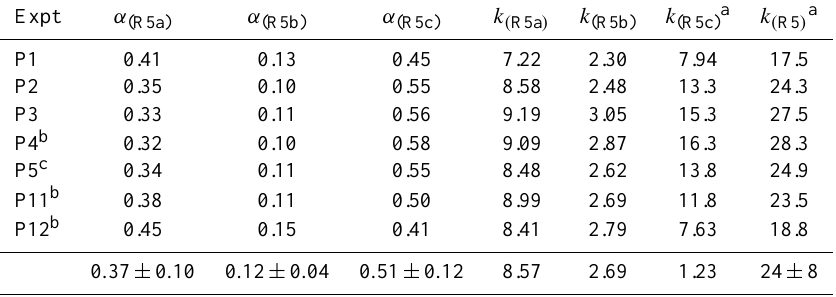
Table 3. Branching ratios for Reaction (R5) determined by fitting the chemical model to the experimental data, allowing the chemical simulation to optimise k (R5a) , k (R5b) and k (R5c) independently. The total rate coefficient was determined from the fitting procedure also listed k (R5) . The bottom row displays average values and calculated standard deviations ( ± 2 σ) . Expt α (R5a) α (R5b) α (R5c) k ( R5a ) k (R5b) k (R5c)a